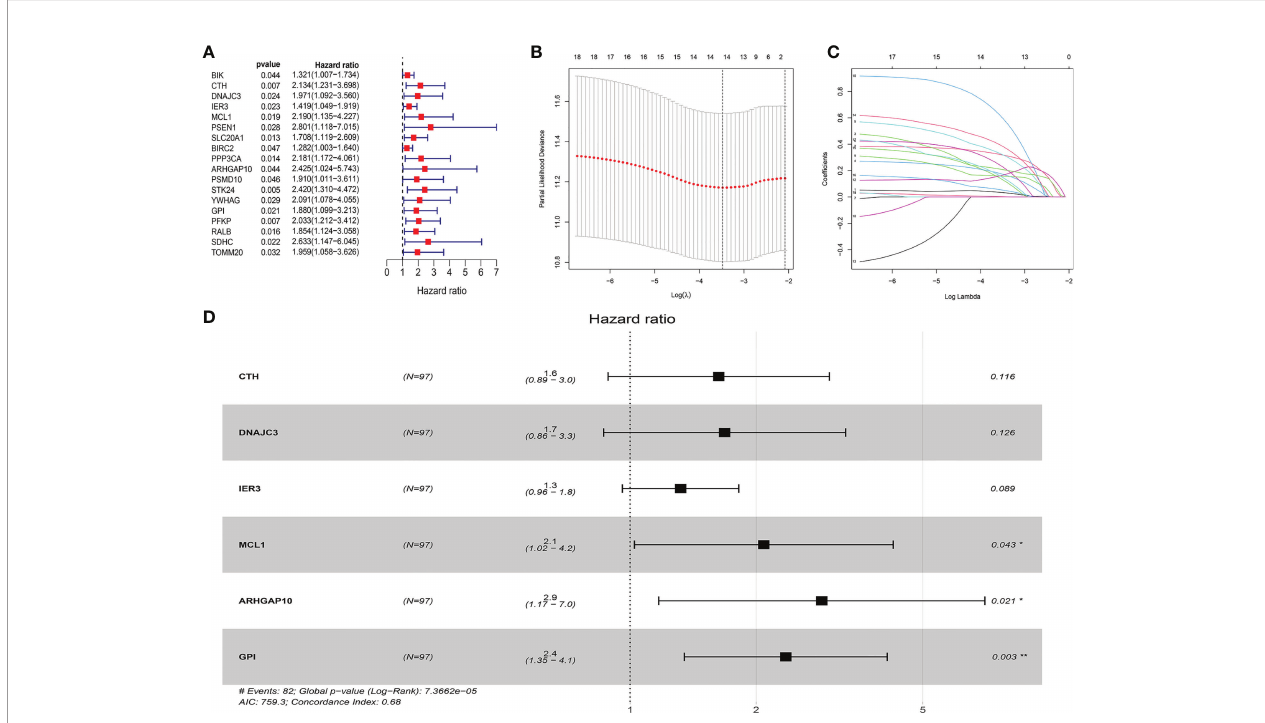
FIGURE 1 | Construction of the ARG model in the internal training dataset. (A) Forest plot showed that 18 risk genes were identi fi ed as prognostic ARGs through univariate Cox regression analysis (HR >1, p < 0.05). (B, C) LASSO analysis further picked up 14 ARGs. (D) The multiple Cox regression screened six independent predictors (CTH, DNAJC3, IER3, MCL1, GPI, ARHGAP10) of